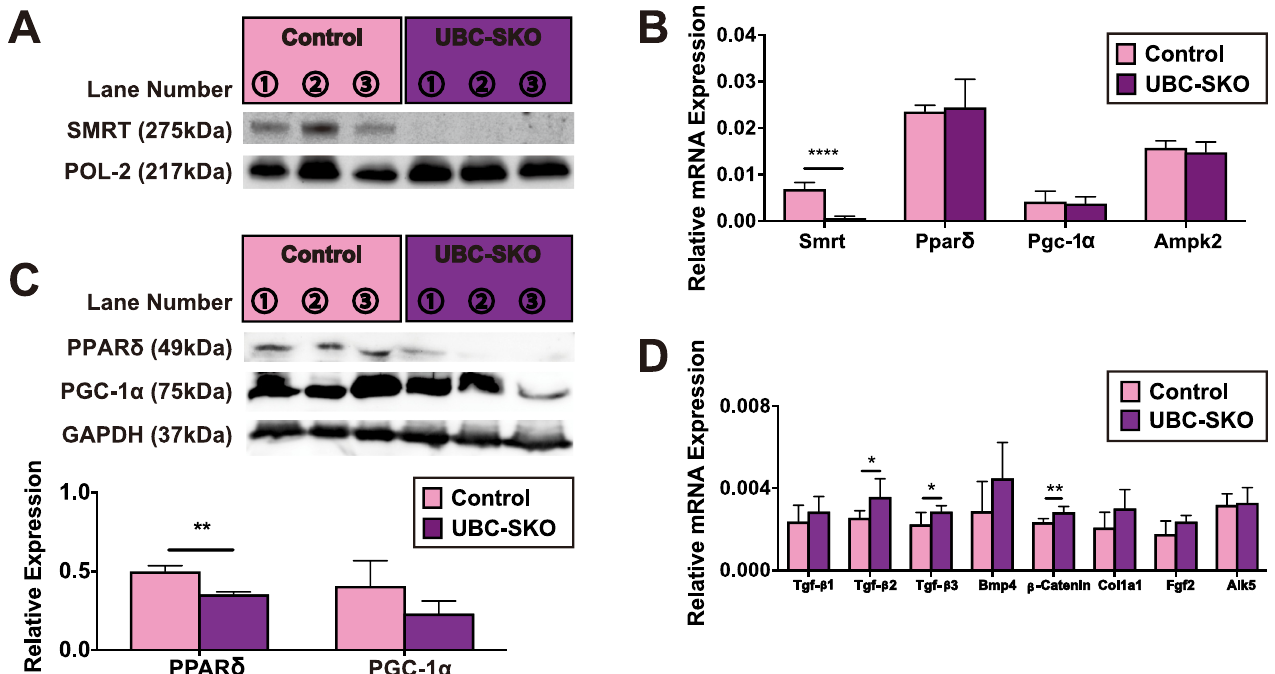
Fig 5. Post-natal SMRT deletion has minimal effects on both β -oxidation and Tgf- β signaling in in vivo mouse skeletal muscle. (A) Protein levels of SMRT in the skeletal muscle of both UBC-SKO and control mice was assessed by WB (n = 3 mice/group). (B) The expressions of Smrt and β -oxidation-related genes in the skeletal muscle of both UBC-SKO and control mice were quantified by qPCR (n = 5–6 mice/group). (C) Protein expressions of PPAR δ and PGC-1 α in the skeletal muscle of both UBC-SKO and control mice were assessed by WB (n = 3 mice/per group). (D) The expressions of Tgf- β receptor signaling-related genes and markers of fibrosis in the skeletal muscle of both UBC-SKO and control mice were quantified by qPCR (n = 5–6 mice/group). Student t-tests were used for statistical analyses in all qPCR and quantification of protein expression. All results are shown as the mean ± SEM (error bars represent SEM), the p- value was shown as; ���� , p < 0.0001; �� , p < 0.01; � , p <